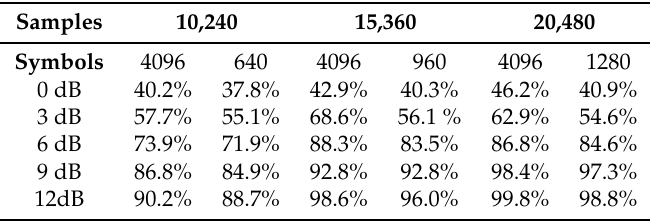
Table 3. Comparison for Ω 2 between CS method and classical method with equivalent number of